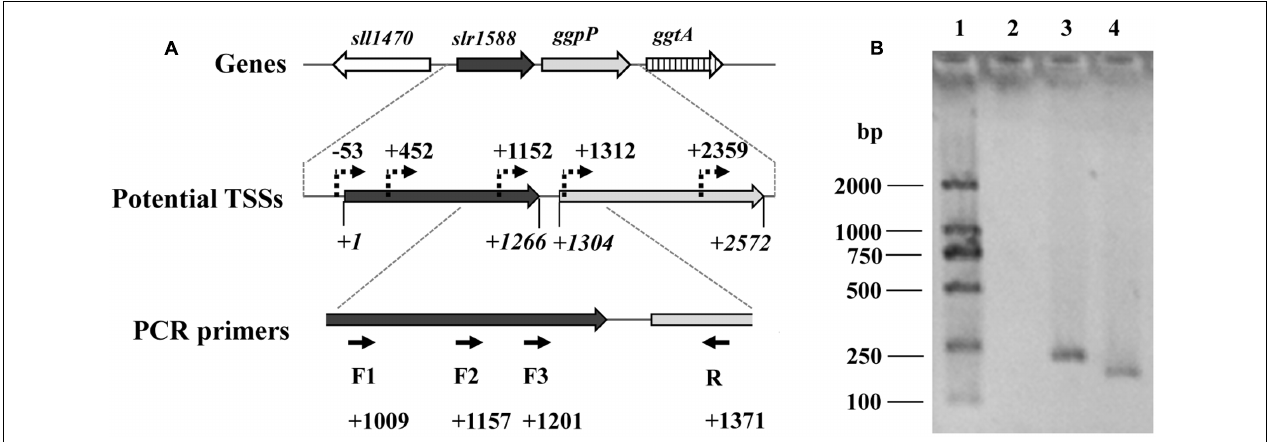
FIGURE 2 | Analysis of the ggpP transcription by RT-PCR. (A) . The potential TSSs of ggpP inside slr1588 predicted by dRNA-seq (Kopf et al., 2014) were labeled as dotted arrows. The translation start site of slr1588 was set as + 1, and the relative locations of these TSSs inside the ORF of slr1588 or ggpP were calculated. For RT-PCR, three forward primers (F1, 2 and 3, binding sites inside slr1588 are indicated) specific to slr1588 and a reverse primer (R) specific to ggpP were designed. (B) . Separation of DNA-fragments obtained by RT-PCR using cDNA of salt-grown cells of the wild type (WT) strain as template. Lane 1: a DNA ladder; Lane 2, 3 and 4: three primer pairs (F1/R, F2/R, and F3/R) were used for amplification,